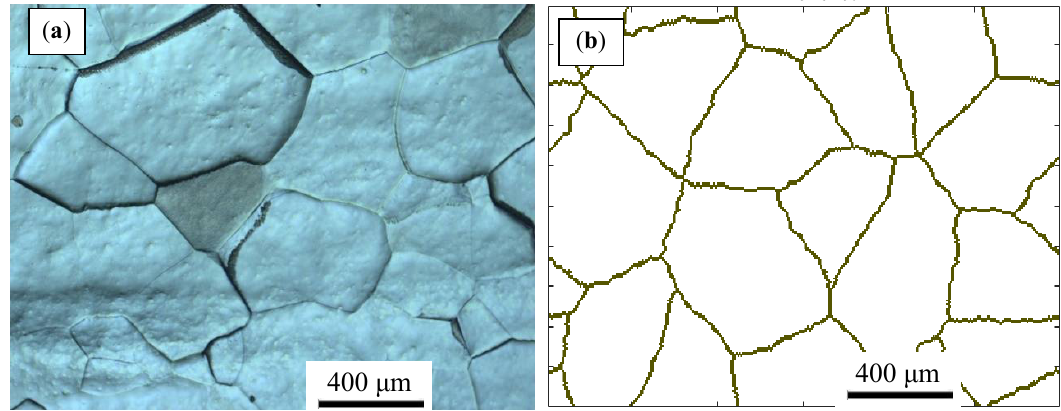
Figure 1. ( a ) Microstructure of the 47Zr-45Ti-5Al-3V alloy solution-treatment at 1050 °C for 0.5 h. ( b ) Initial microstructure simulated by CA.